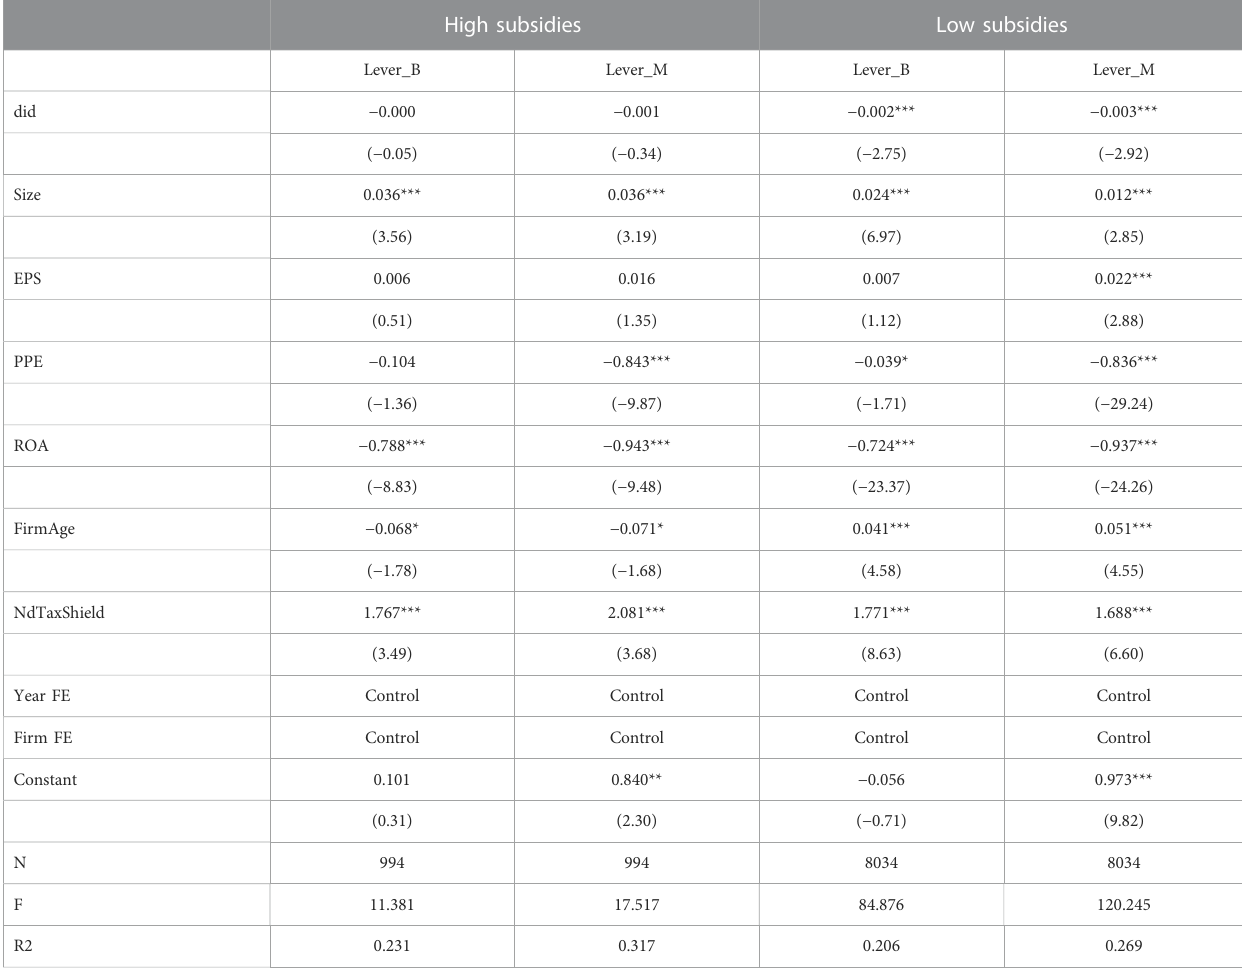
TABLE 11 Carbon trading and corporate capital structure under different government subsidies. High subsidies Low